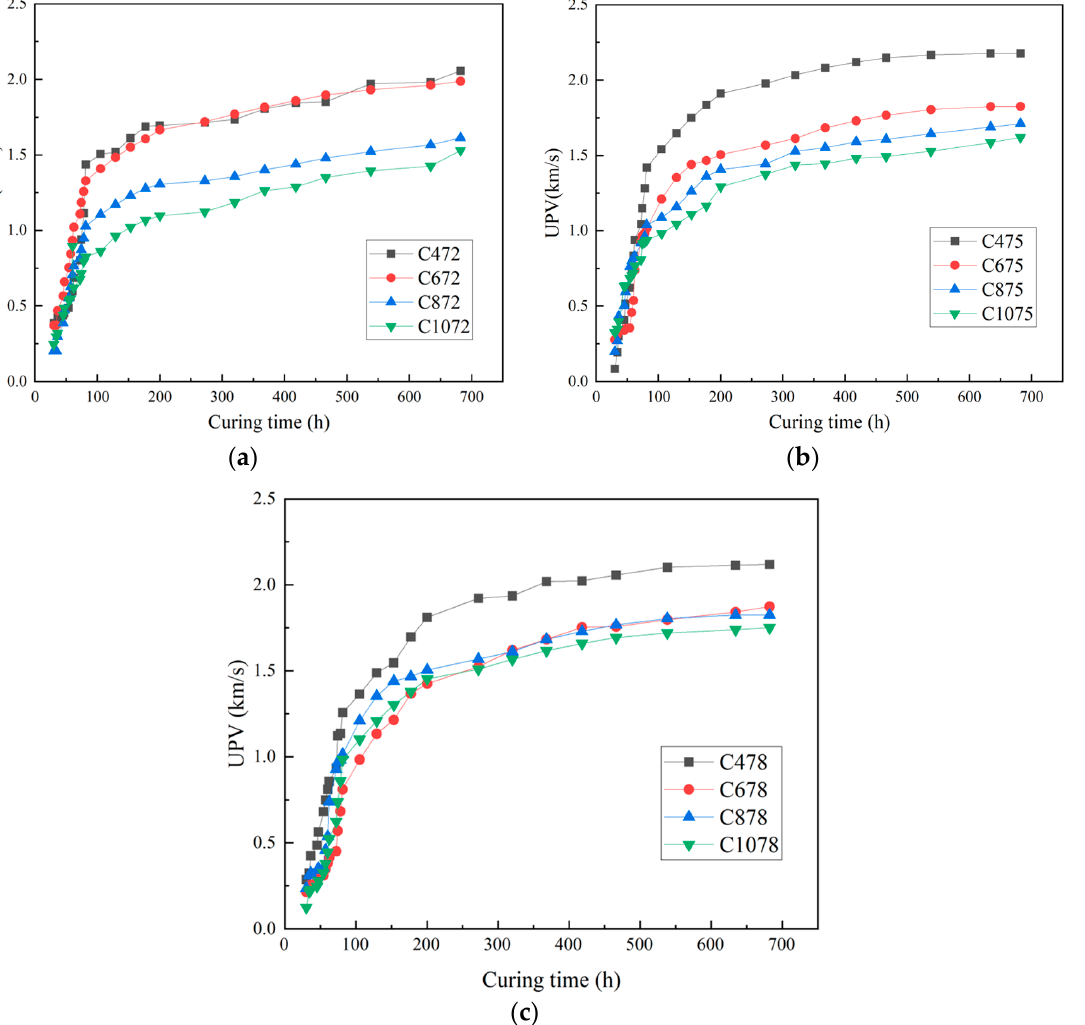
Figure 4. UPV development of CTB with different: ( a ) solid content of 72%; ( b ) solid content of 75% ( c ) solid content of 78%.